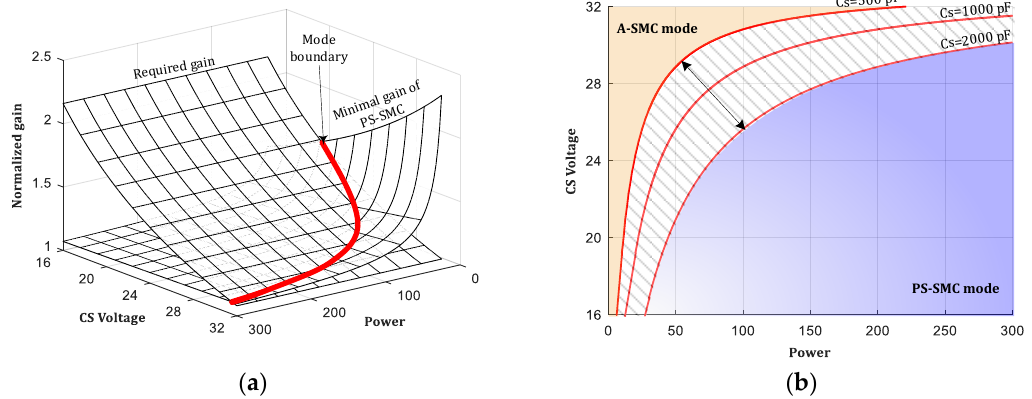
Figure 4. Derivation of the borderline between PS- and A-SMC modes for C s = 1 nF ( a ); theoretical mode boundaries for various C s values ( b ).